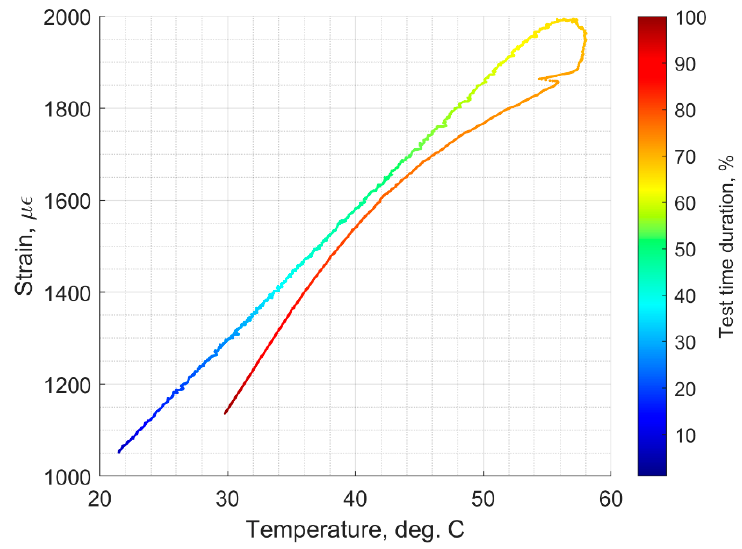
Figure 25. Corrosion sensor strain versus temperature.